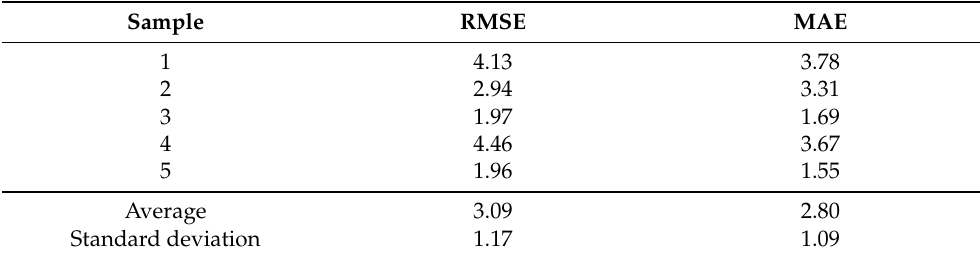
Table 7. Best results using AutoKeras with